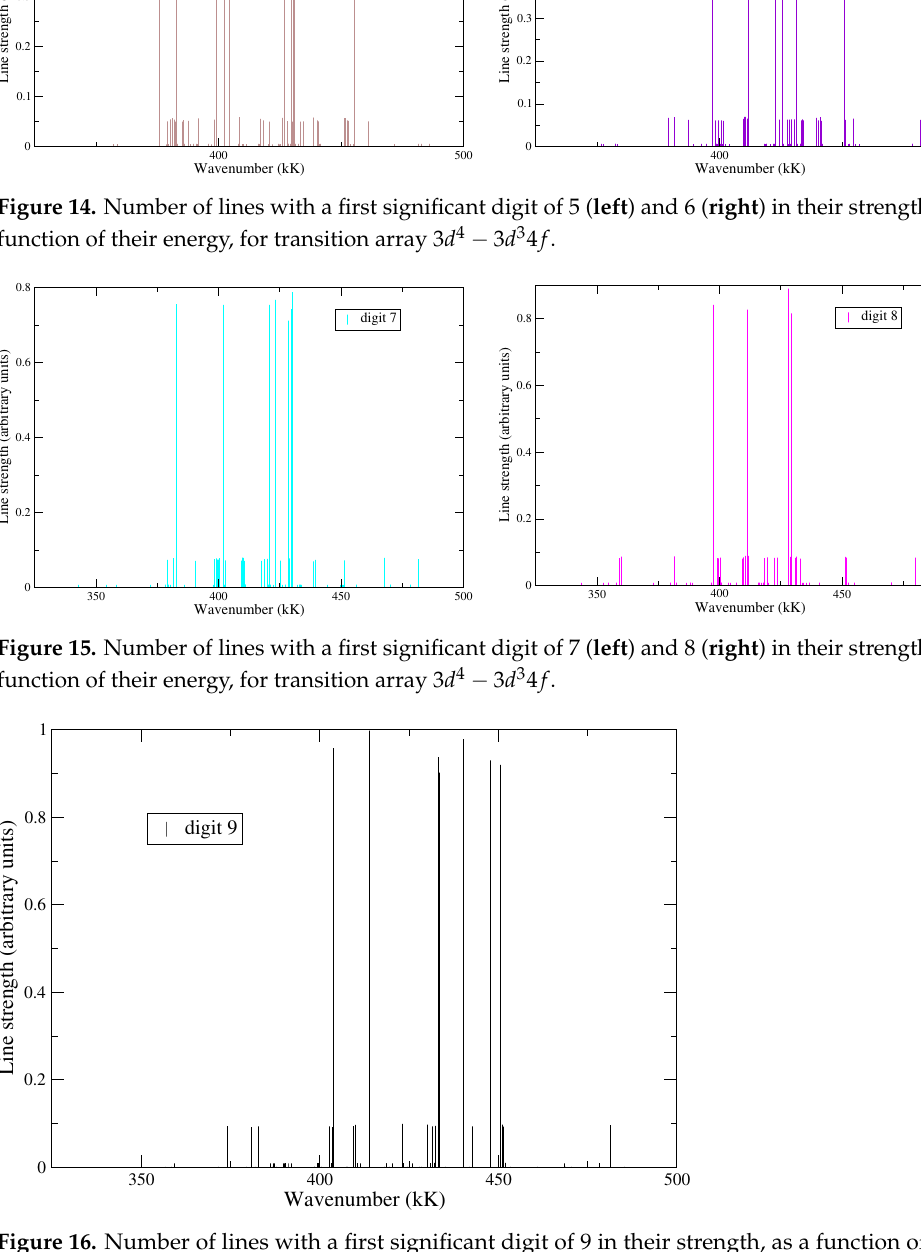
Figure 16. Number of lines with a first significant digit of 9 in their strength, as a function of their energy, for transition array 3 d 4 3 d 3 4 f −